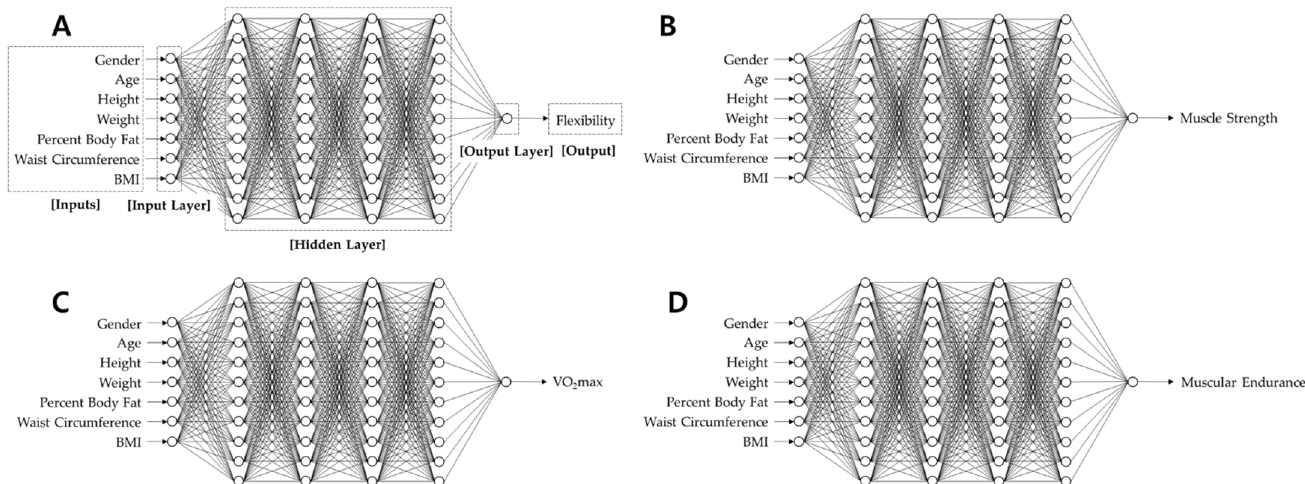
Figure 1. Overall architecture of the ANN-based HRPF level estimation model. ( A ) Architecture of the ANN model for predicting flexibility with descriptions, ( B ) Architecture of the ANN model for predicting muscle strength, ( C ) Architecture of the ANN model for predicting VO 2 max, ( D ) Architecture of the ANN model for predicting muscular endurance.